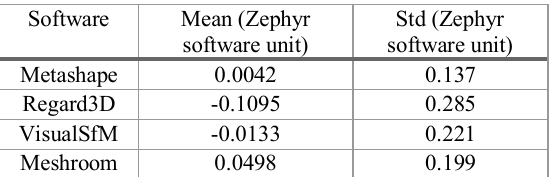
Table 8. Results of M3C2 comparisons (mean and standard